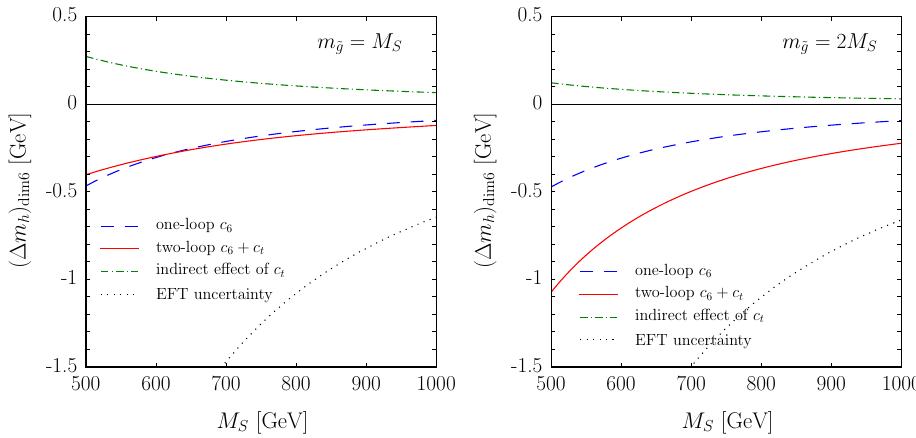
Fig. 3 Effects of dimension-six operators on the EFT prediction for the Higgs mass, as a function of a common stop mass scale M S , for √ X t = 6 M S . In the left plot we take m ˜ g = M S , whereas in the right